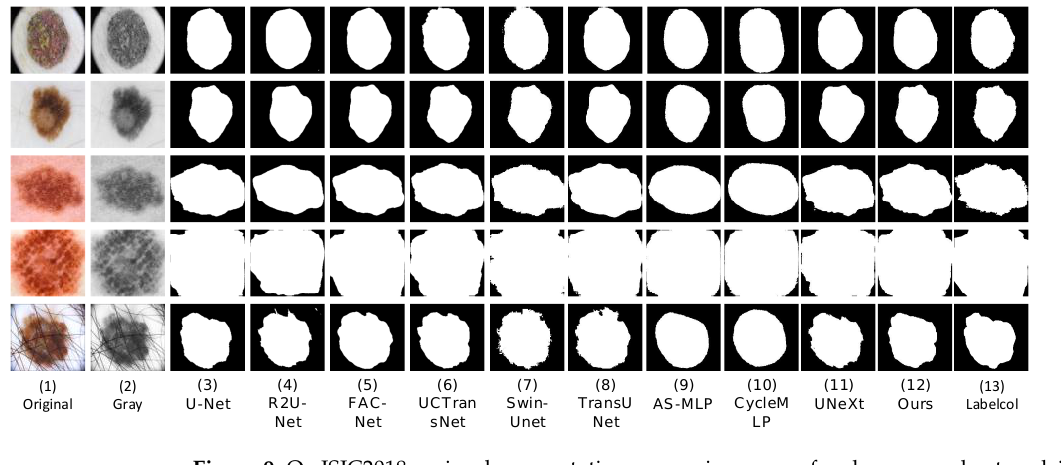
Figure 9. On ISIC2018, a visual segmentation comparison map of each compared network is displayed. ( 1 , 2 ) The input original image and grayscale image, respectively, and ( 13 ) the label-col map. ( 3 – 11 ) The comparison network segmentation results, and ( 12 ) the method in this paper segmentation results. It can be seen that the segmentation results of the method in this paper are the closest to the label-column diagram.